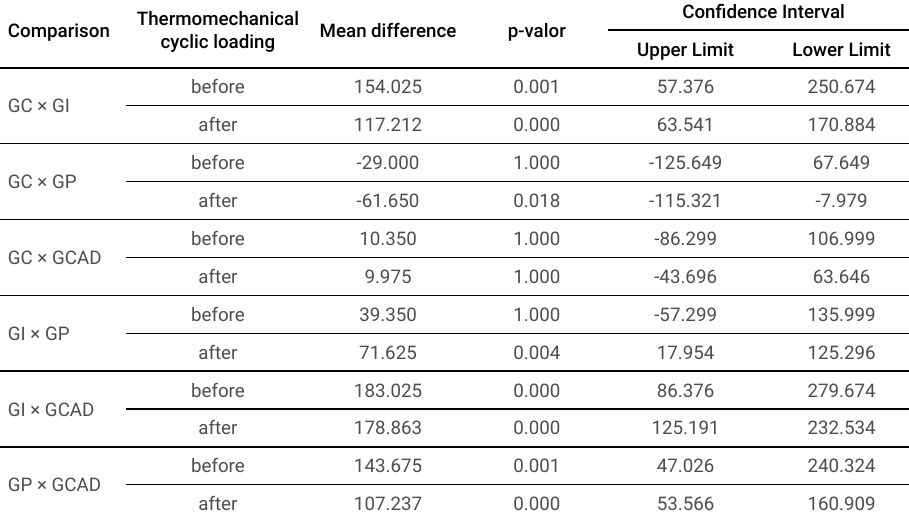
Table 1. Comparison of Vickers microhardness (HV) before and after thermomechanical cycling.